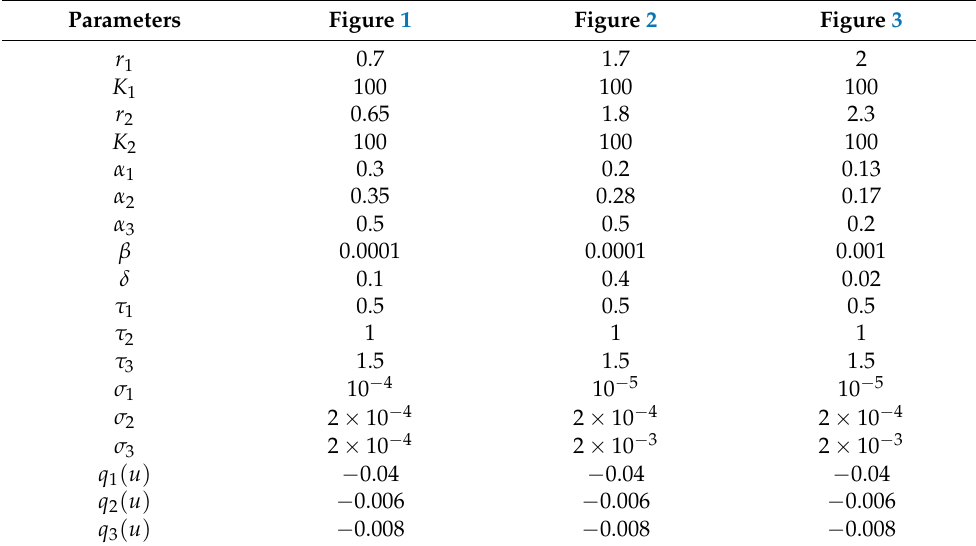
Table 2. Values of the parameters used in the numerical simulations.